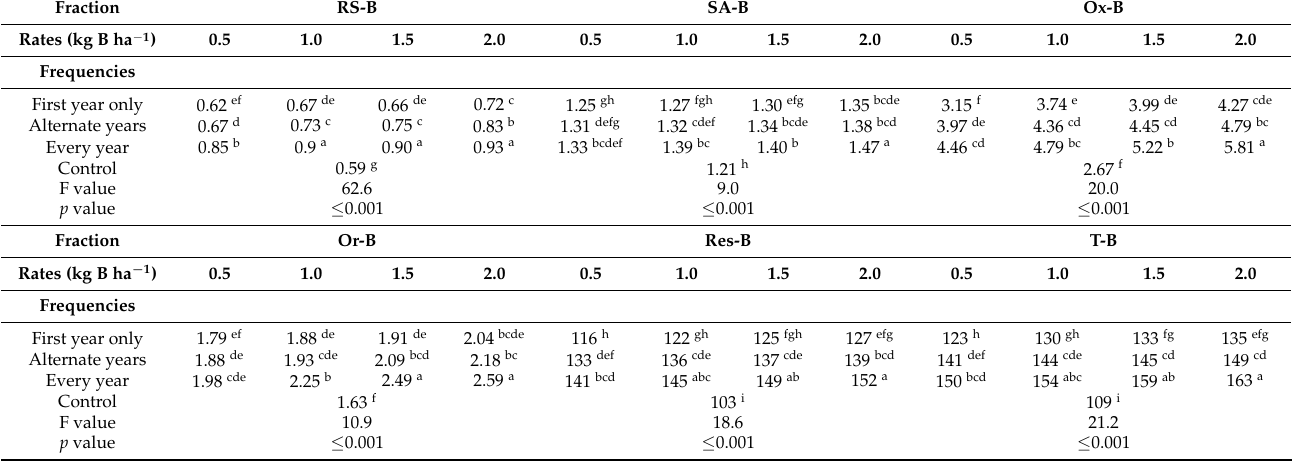
Table 4. Boron fractions (mg kg − 1 ) as influenced by various dosages of B addition to the groundnut- cabbage cropping